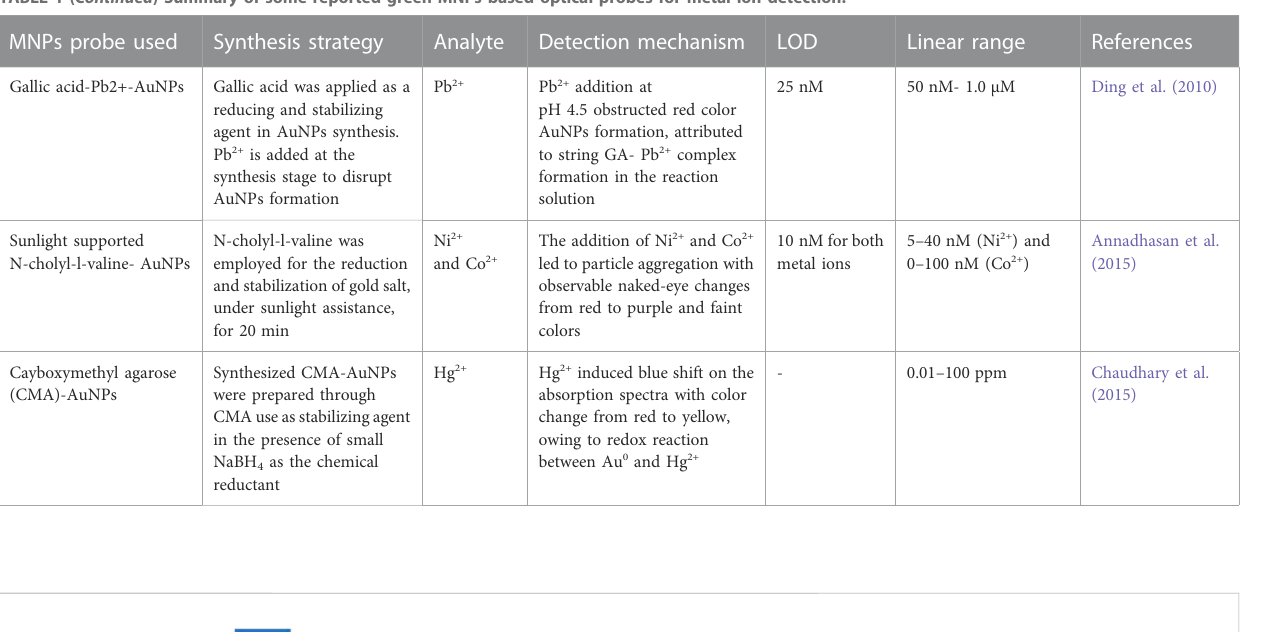
TABLE 1 ( Continued ) Summary of some reported green MNPs based optical probes for metal ion detection.